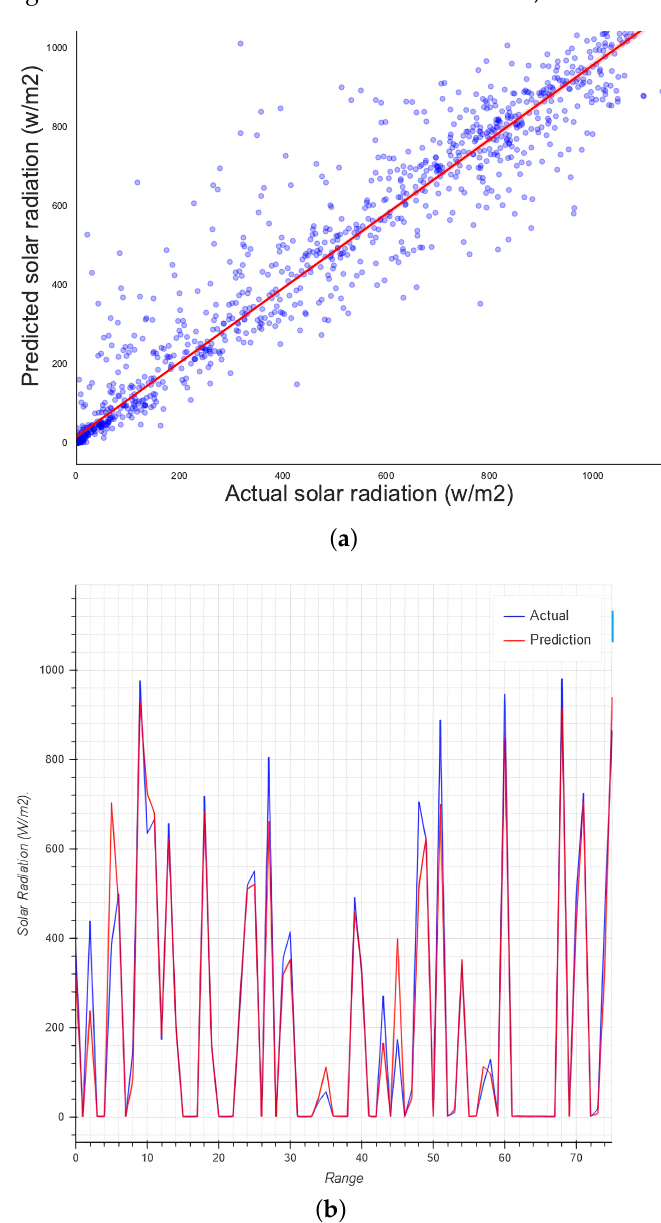
Figure 13. ( a ) Regression plot for the method proposed in Algorithm 1 and ( b ) validation plot for the method proposed in Algorithm 1. Table 3. Results obtained after determining the best features for the RF